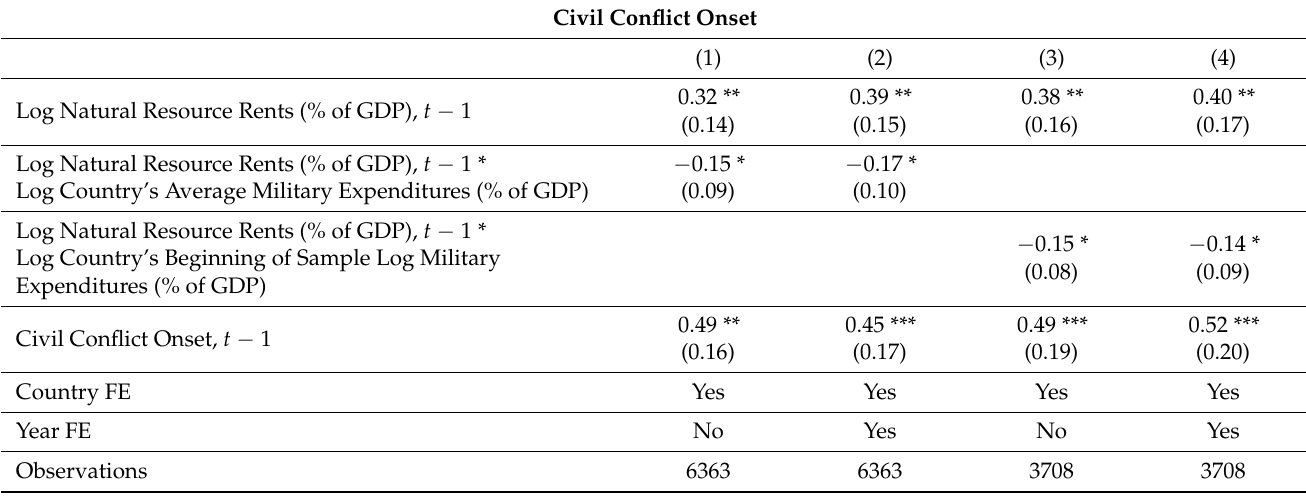
Table 8. Robustness: Countries’ Average or Beginning of Sample Military Expenditures. Civil Conflict